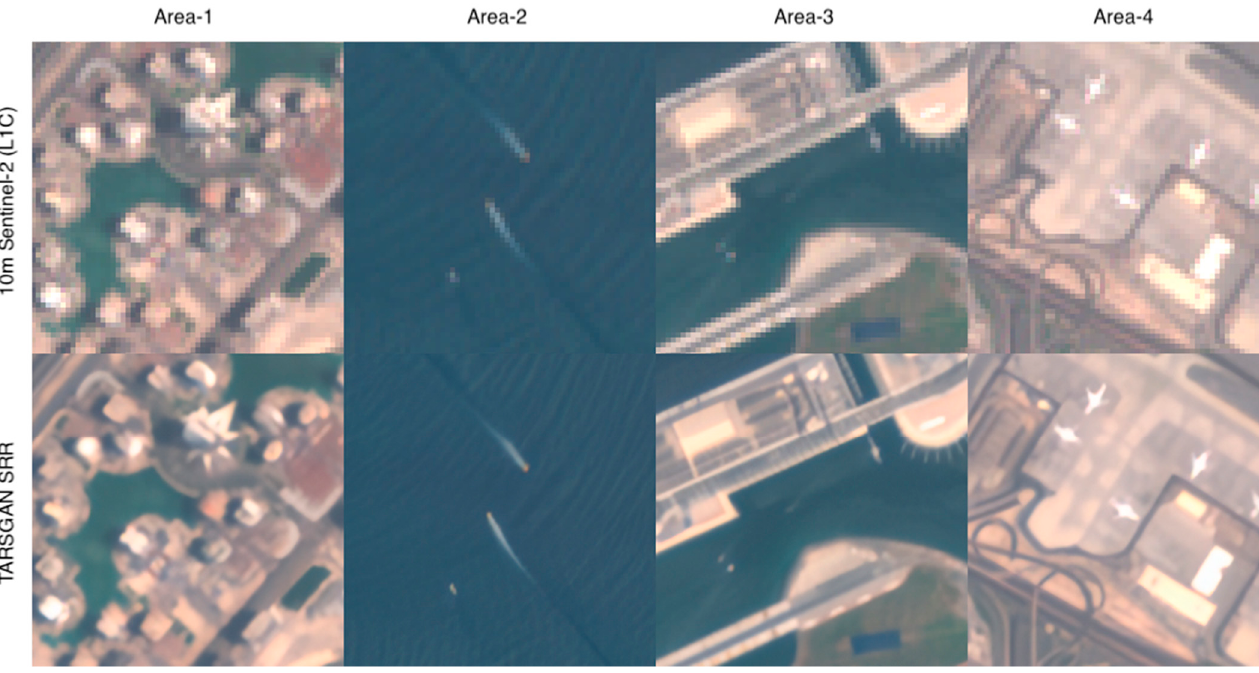
Figure 8. Cropped examples (625 m × 625 m) of the 10 m/pixel Sentinel-2 “true” colour images (L1C) and TARSGAN SRR result over Dubai, United Arab Emirates (Site-2). Please refer to supplementary material for full-size SRR (produced from Sentinel-2 S2B_MSIL1C_20210528T064629_N0300_R020 T40RCN_20210528T084809).